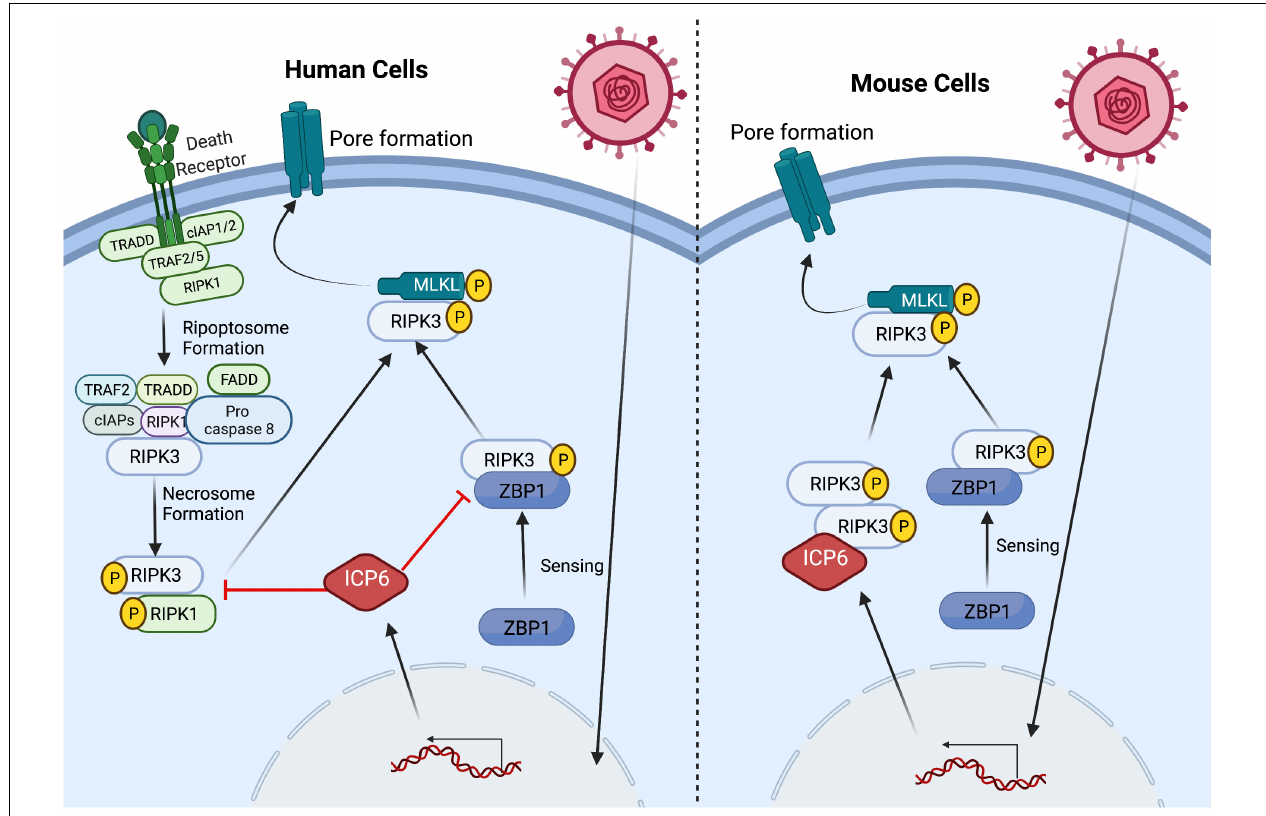
FIGURE 2 | HSV1 manipulates the necroptosis pathway in a species-specific manner. Triggering of necroptosis via several upstream signaling pathways is dependent on the activation of the RHIM-containing protein RIPK3 which, in turn, mediates MLKL oligomerization and translocation to the plasma membrane resulting pore formation and ultimately cell death (see text). HSV1 manipulates the necroptosis pathway through virus-encoded ICP6 RHIM-mediated interaction with RHIM-containing host proteins, but the outcome of this interaction results in species-specific outcomes. In HSV1-infected human cells, ICP6 acts as a RHIM competitive inhibitor and restricts necroptosis by sequestering RIPK3 from its cellular partners ZBP1 and RIPK1. In contrast, ICP6 expression in HSV1-infected mouse cells results in ICP6 RHIM dependent recruitment of RIPK3 that drives necroptosis. HSV1 infection triggers RIPK3-mediated necroptosis via ZBP1 sensing z-form RNA in both human and mouse